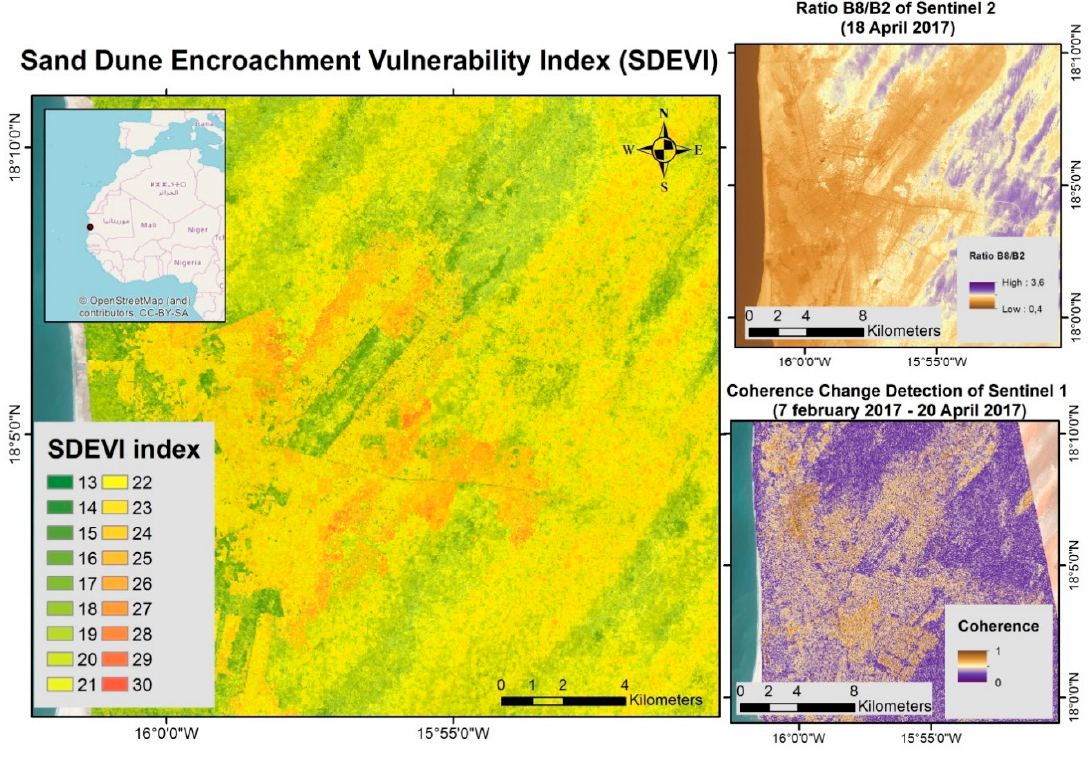
Figure 11. SDEVI map, ratio B8/B2 image of Sentinel 2 from 18 April 2017, and Coherence image from 7 February 2017–20 February 2017.